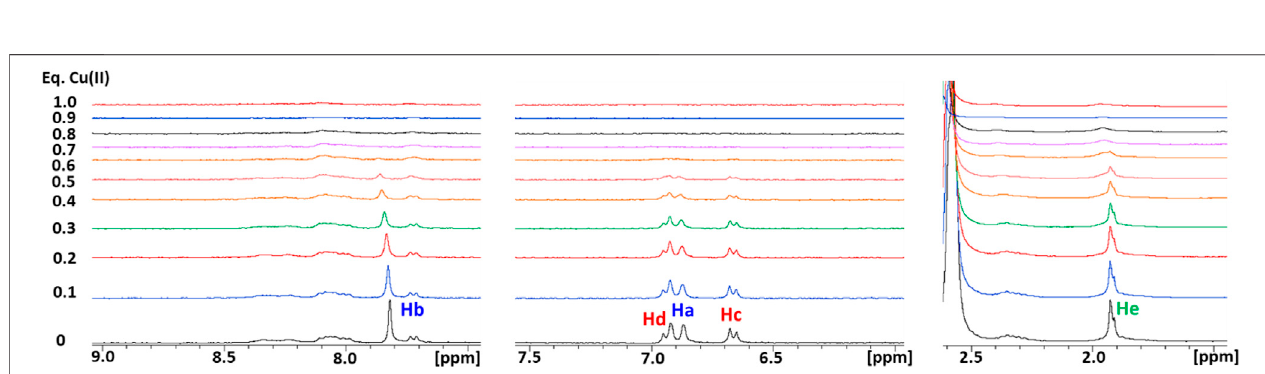
FIGURE3| Overlayofthreeregionsof1D 1 HNMRspectraofCtr1 1-14 in10 mMMES(pH7)atdifferentCu(II):peptideratios.Protonassignmentschemeasshown in Figure 1C .